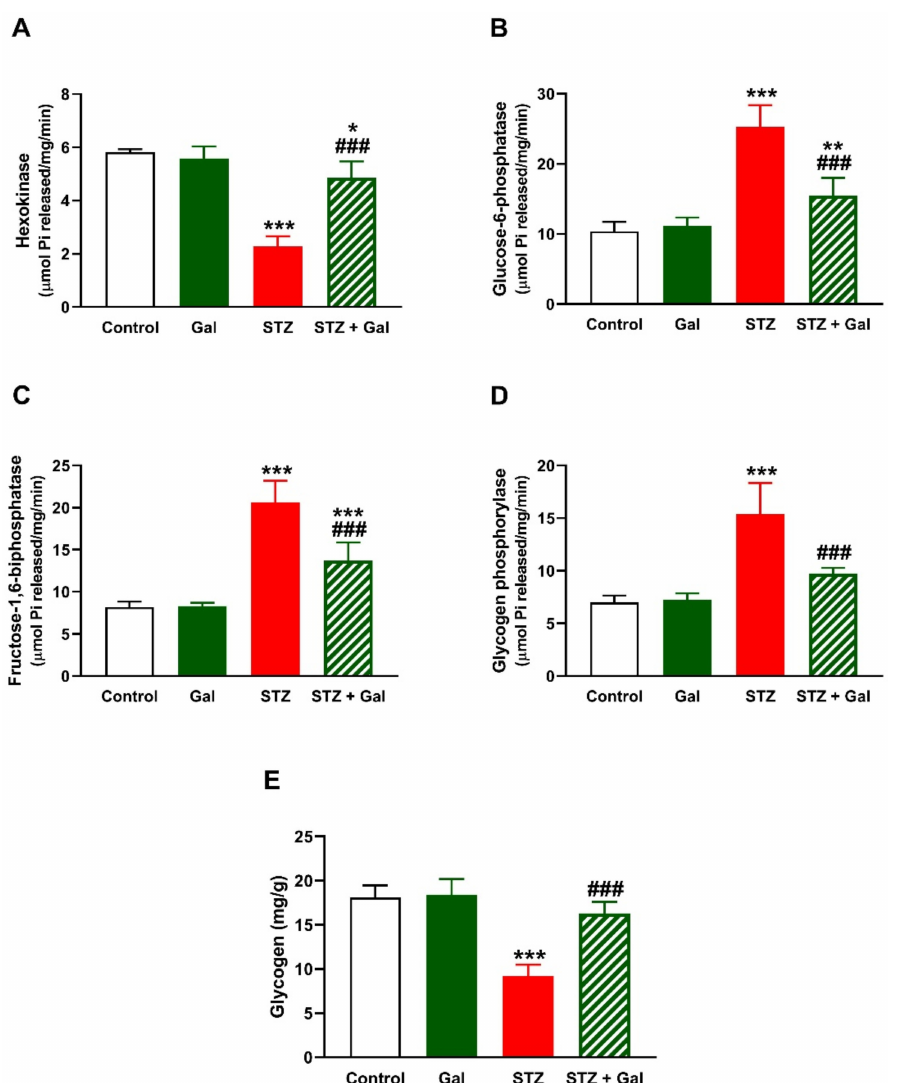
Figure 2. Galangin improves hepatic carbohydrate metabolism in diabetic rats. Galangin increased hepatic hexokinase activity ( A ), decreased glucose-6-Pase ( B ), fructose-1,6-BPase ( C ), and glycogen phosphorylase ( D ) and increased liver glycogen ( E ) in diabetic rats. Data are mean ± SEM, n = 6. * p < 0.05, ** p < 0.01 and *** p < 0.001 versus control. ### p < 0.001 versus